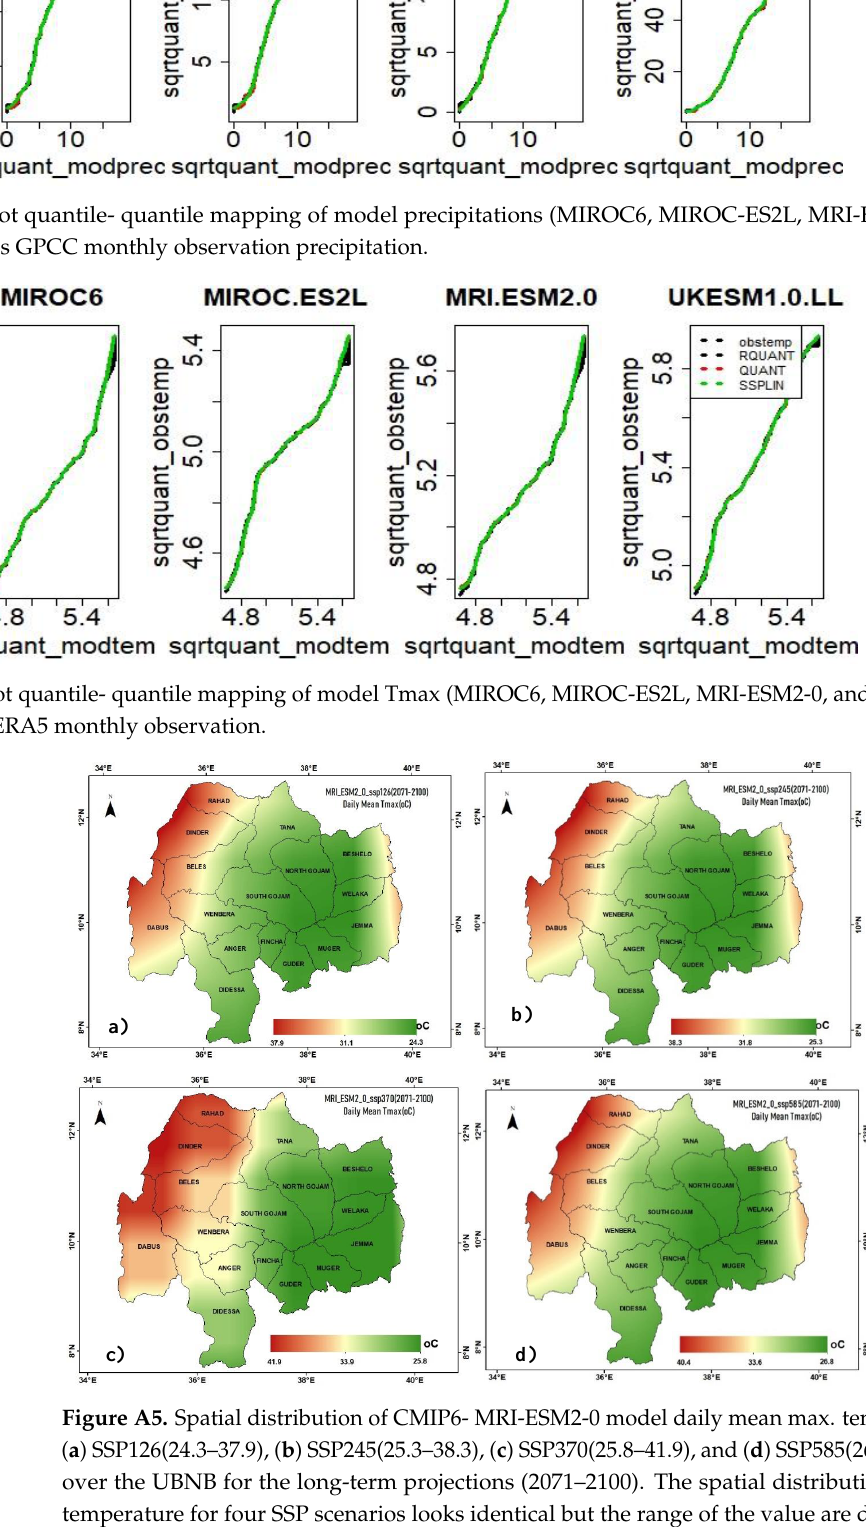
Figure A6. Spatial distribution of CMIP6- MRI-ESM2-0 model daily mean max. temperature (°C) for ( a ) SSP126(24.3 – 37.9), Figure A5. Spatial distribution of CMIP6- MRI-ESM2-0 model daily mean max. temperature ( ◦ C) for ( b ) SSP245(25.3 – 38.3), ( c ) SSP370(25.8 – 41.9), and ( d ) SSP585(26.8 – 40.4) scenarios over the UBNB for the long-term projec- ( a ) SSP126(24.3–37.9), ( b ) SSP245(25.3–38.3), ( c ) SSP370(25.8–41.9), and ( d ) SSP585(26.8–40.4) tions (2071 – 2100). The spatial distributions of mean max. temperature for four SSP scenarios looks identical but the range of the value are different.